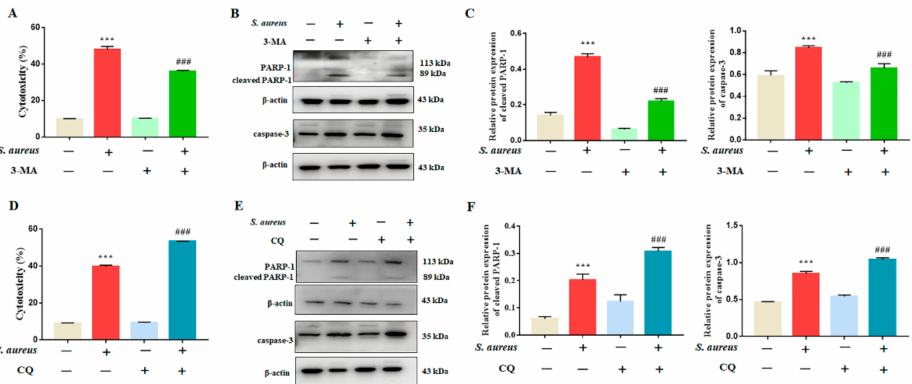
Figure 3. Effect of the inhibition of autophagy on gEECs apoptosis. ( A , D ) Percent cytotoxicity of gEECs infected with S. aureus (10 MOI) for 4 h, having been pretreated with the autophagy inhibitor 3-MA (2.5 mM) and CQ (10 µ M), as determined using an LDH assay. ( B , C , E , F ) The protein expression of LC3II and caspase-3 was measured using Western blot analysis. Each experiment was repeated three times. *** p < 0.001 vs. the mock group, ### p < 0.001 vs. the S. aureus